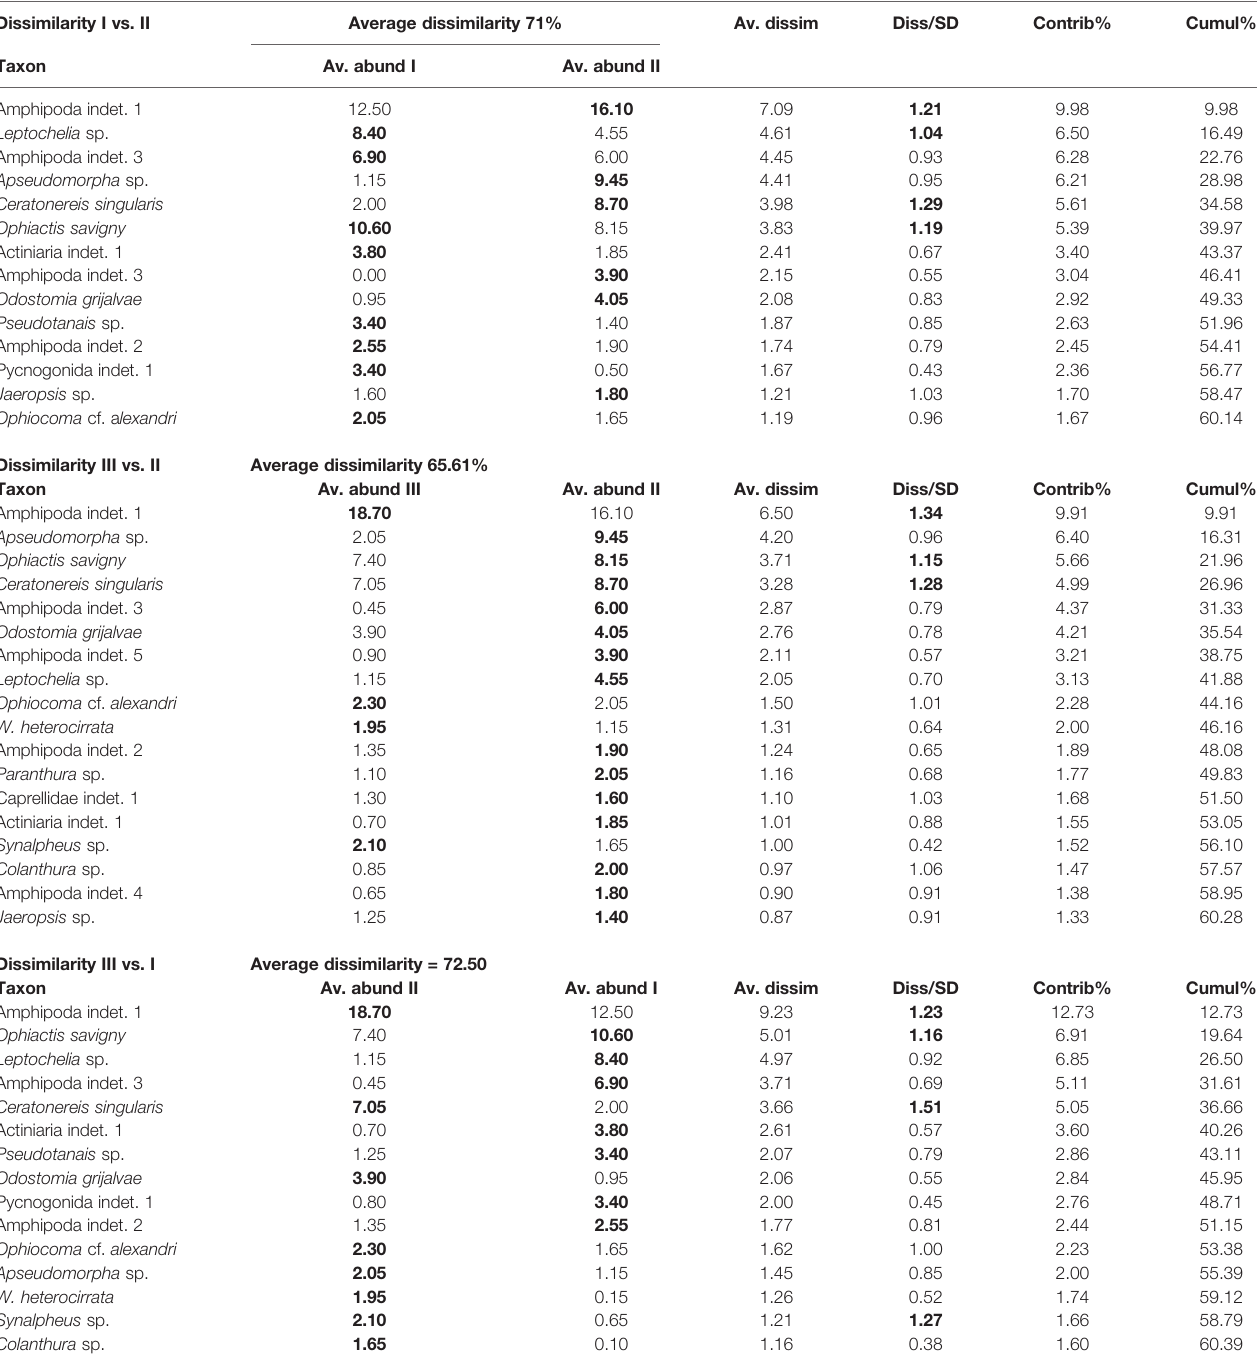
TABLE 8 | Results of the SIMPER analysis with the percentage of contribution by taxon to the dissimilarity between pairs of aggregation levels — I: isolated, II: moderately, and III: highly aggregated. Dissimilarity I vs.